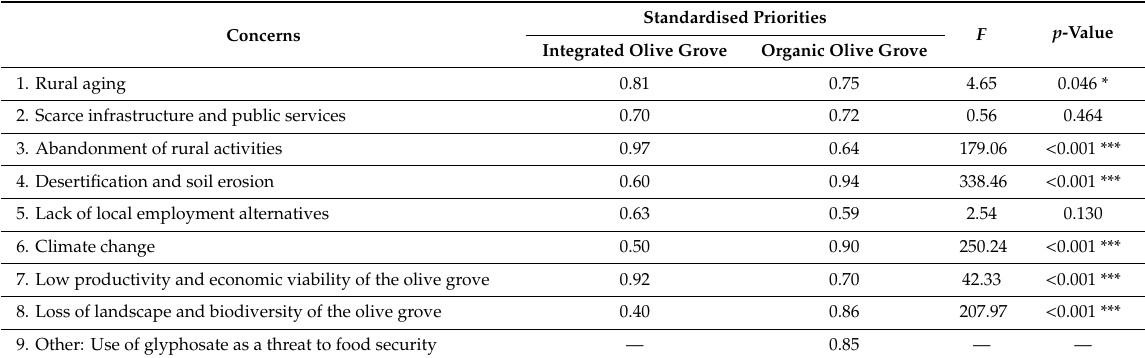
Table 7. Standardised priorities for the main concerns as threats to the agricultural sustainability in the integrated and organic management of olive groves in Estepa region in all erosive states. Statistical values of F (Kruskal–Wallis test) and p -values; significant ( < 0.05 *), very significant ( < 0.01 **), and highly significant ( < 0.001 ***) are shown.